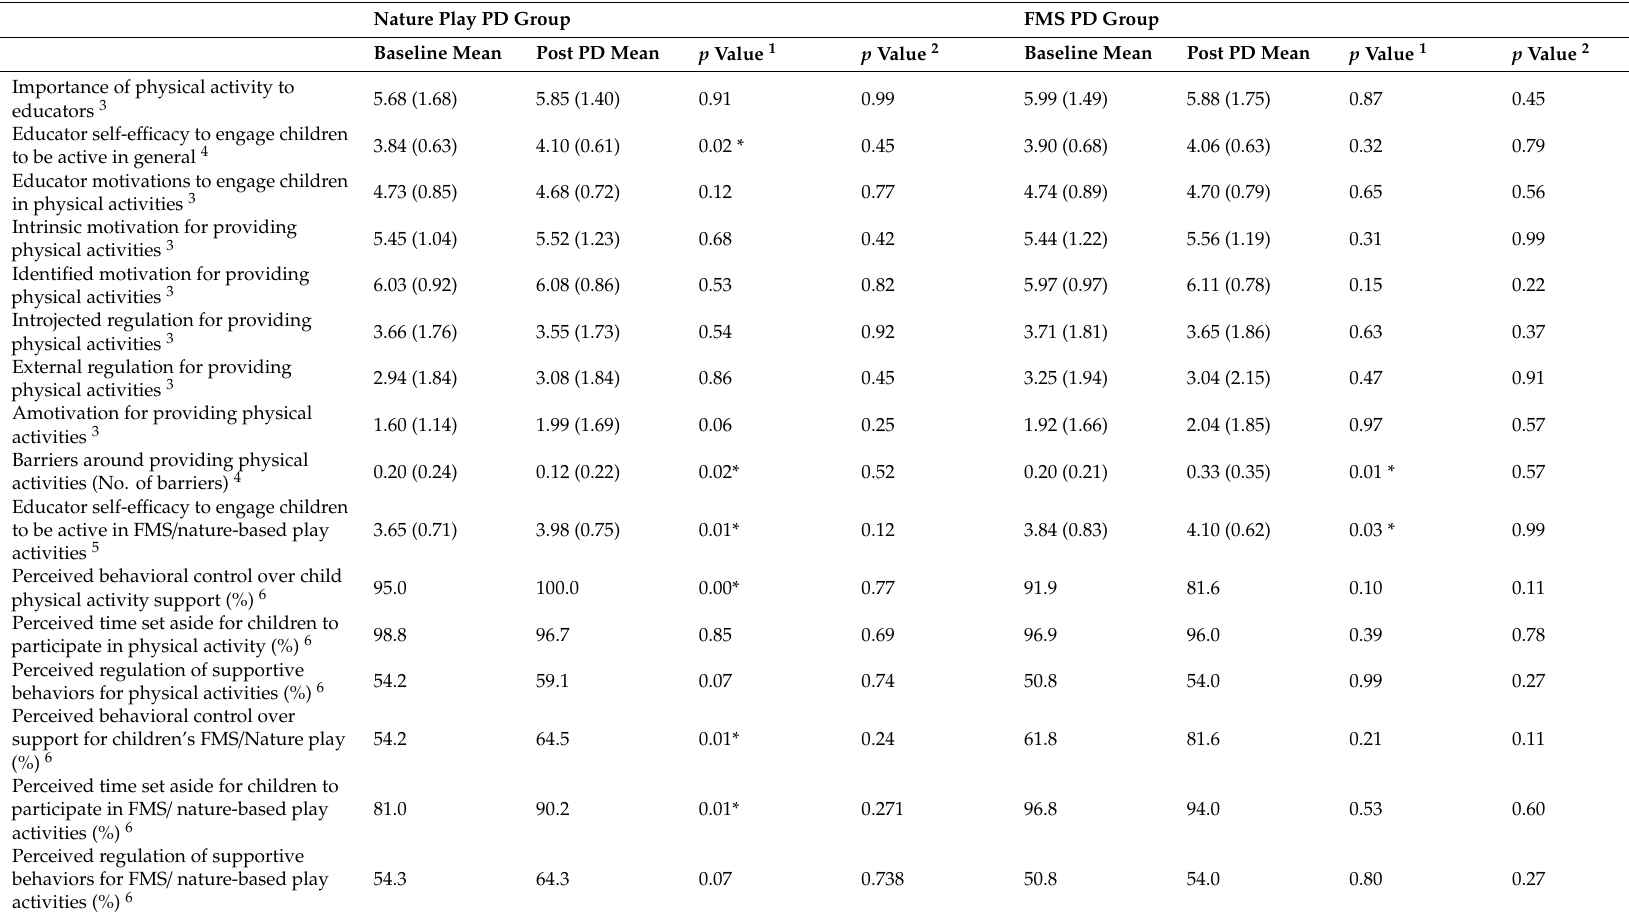
Table 2. Di ff erence between baseline and post-professional development (PD) results using repeated measures general linear